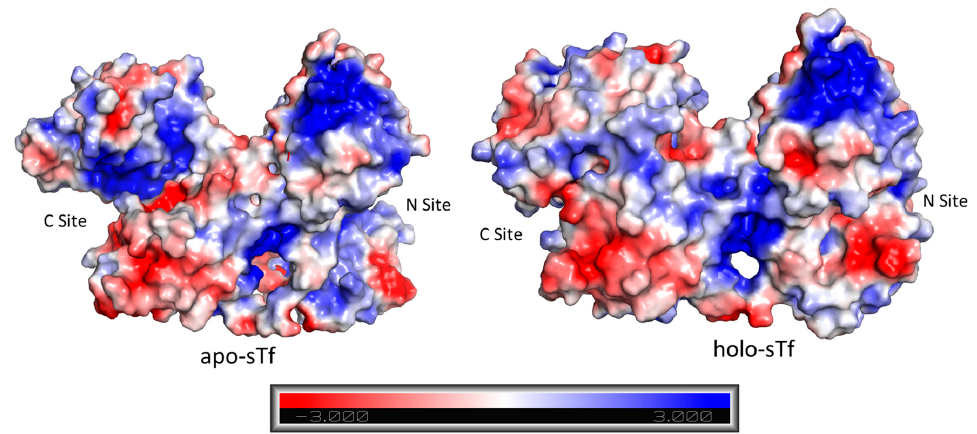
Figure 6. Distribution of the surface charge for apo-sTf (PDB code: 2HAU) and for holo-sTf (Fe 2 -sTf) (PDB code: 3V83). The blue color represents positively charged regions and the red represents negatively charged regions.